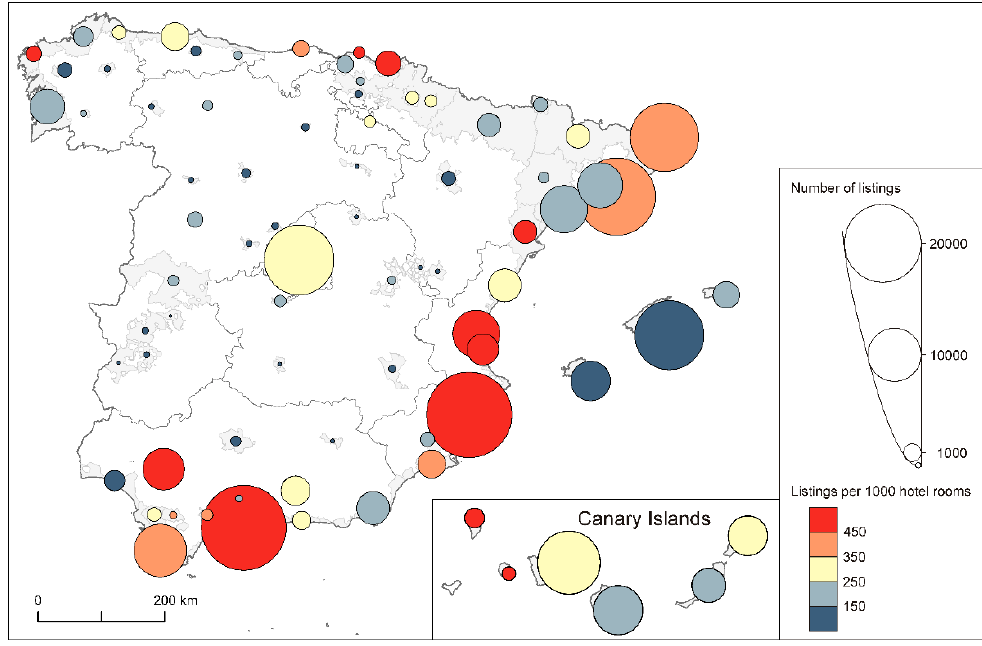
Figure 3. Number of Airbnb listings in Spanish tourist areas/sites.